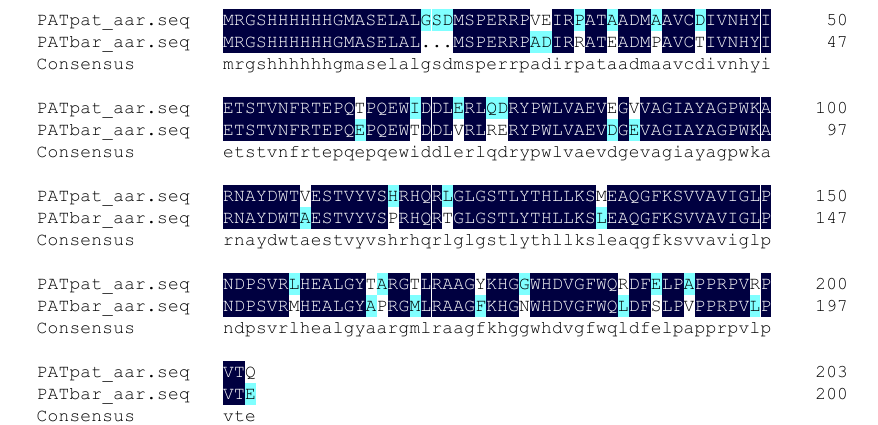
Figure 3. Alignment of PAT/pat (comes from Streptomyces viridochromogenes , Uniprot ID: Q57146) and PAT/bar (comes from Streptomyces hygroscopicus , Uniprot ID: P16426). Sequence identity is indicated by shading.